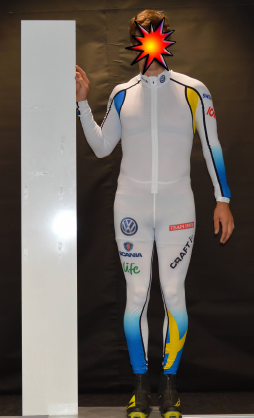
Figure 1. The figure shows the cross-country skier dressed in the racing suit and ski boots, holding the white board used as calibrating area for the image analysis.